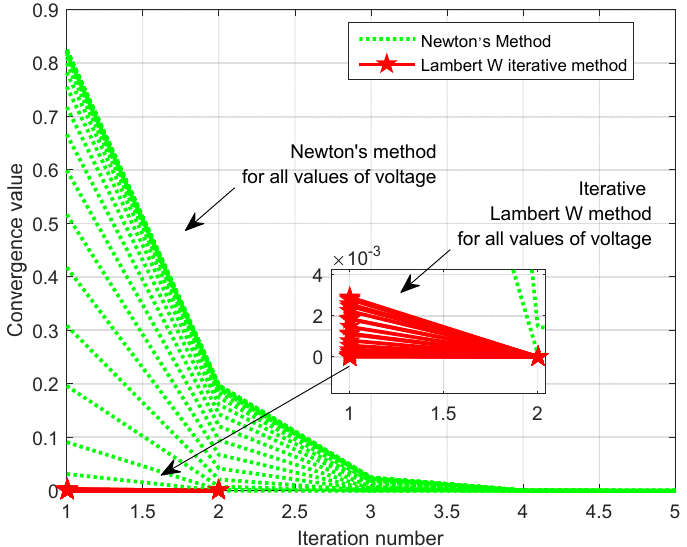
Figure 20. Convergence curves for NM and the ILWF for all values of the measured voltage of the RTC France solar cell.